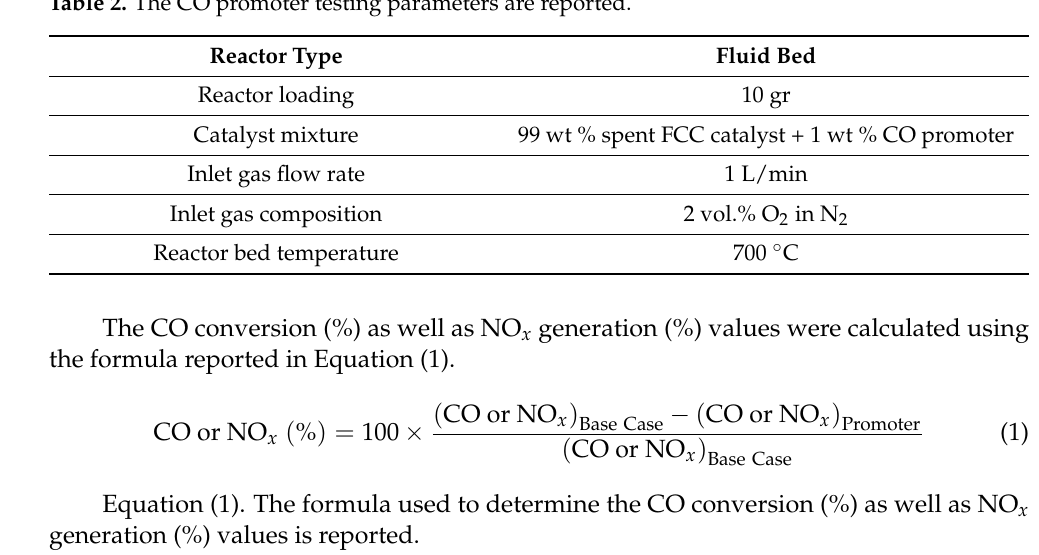
Table 2. The CO promoter testing parameters are